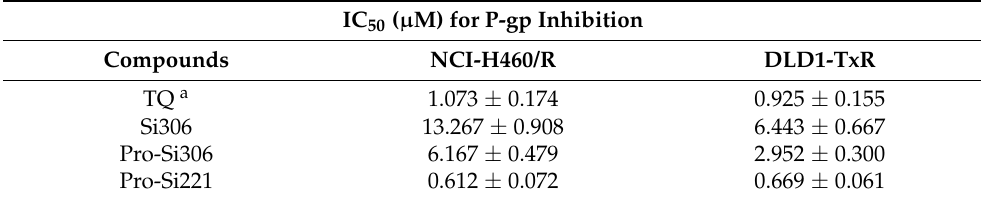
Table 2. P-gp inhibition analyzed by Rho123 accumulation in cells.